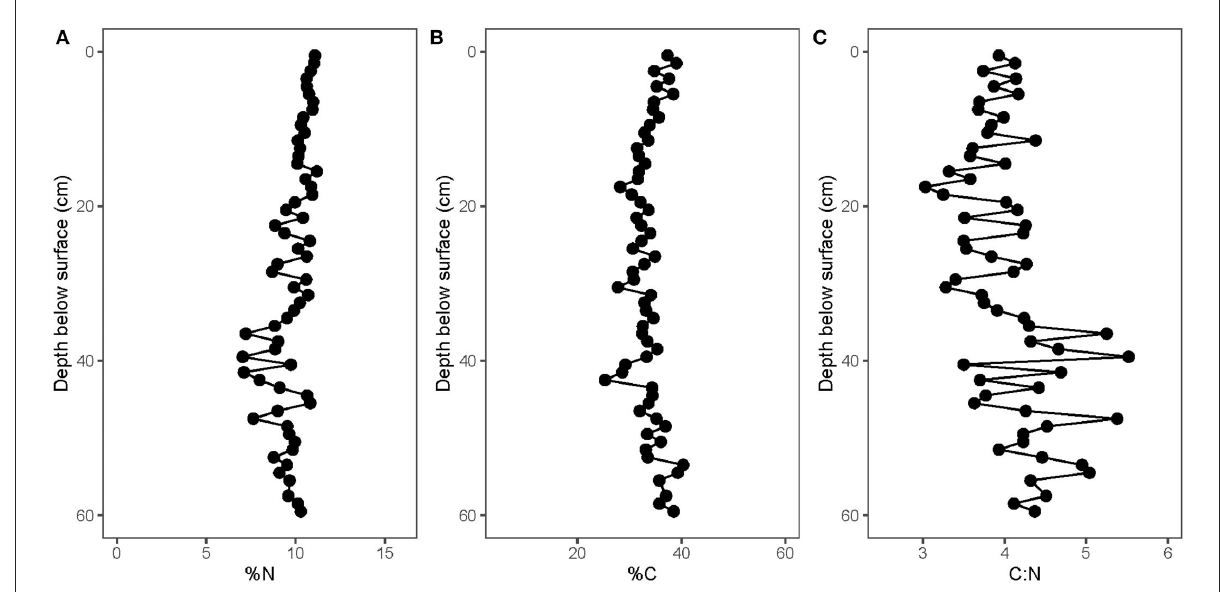
FIGURE4 Variation in guano (A) %N (solvent-extracted), (B) %C (bulk), and (C) C:N with depth.